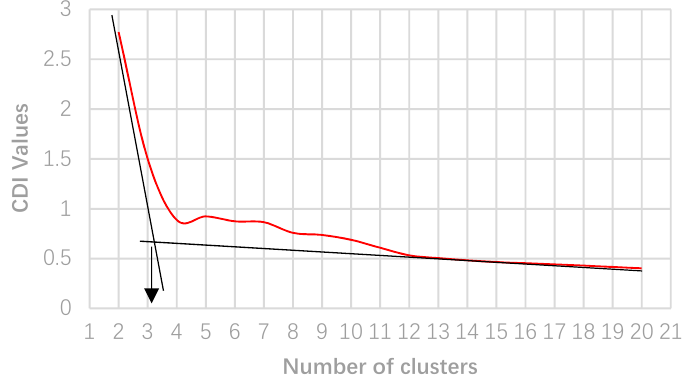
Figure 5. CDI versus the number of clusters.